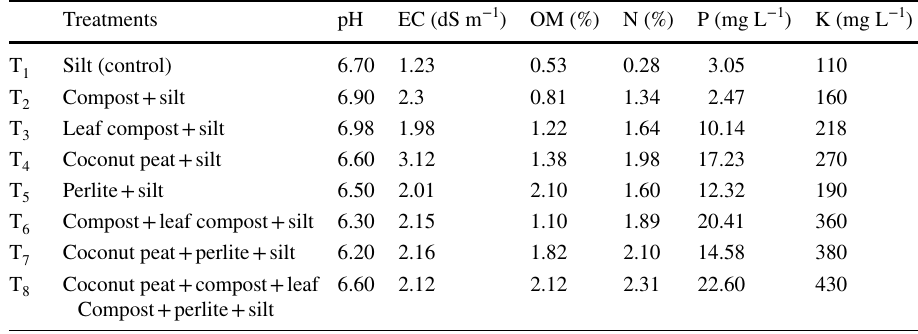
Table 1 Chemical characteristics of growing